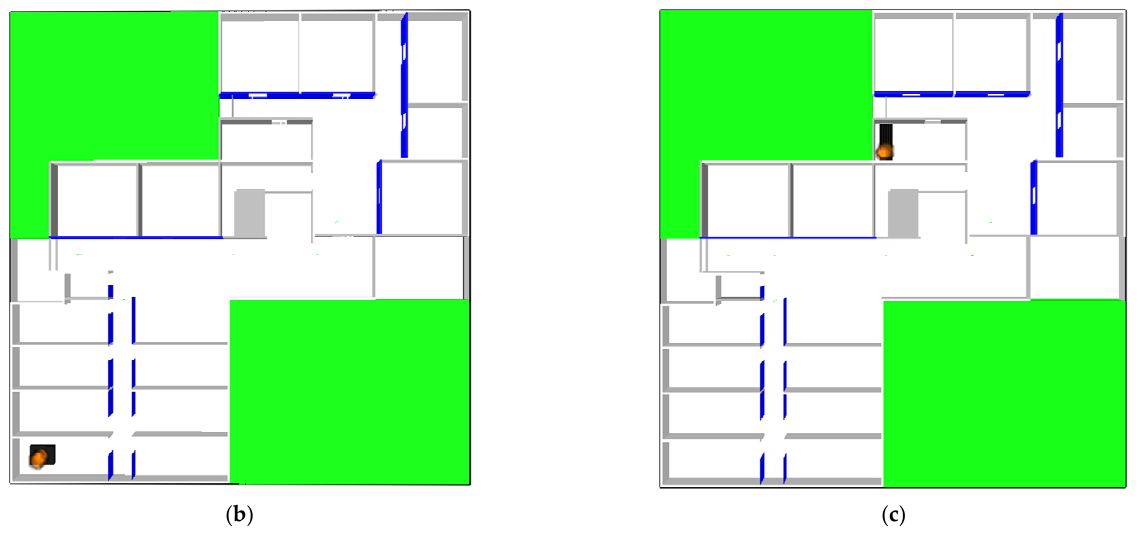
Figure 6. ( a ) Three-dimensional physical model and fire evacuation direction of the nursing home; ( b ) fire point above a bedside and the ignition source was a cigarette butt; ( c ) fire point in the kitchen and the ignition source was a stove.